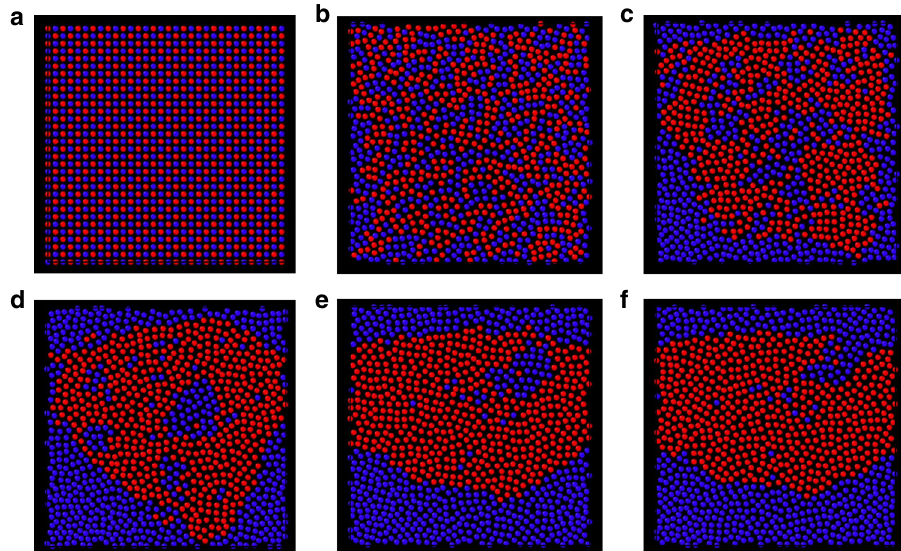
Fig. 8 Segregation of a binary mixture of dissimilar elastic monopoles. a The initial condition for molecular dynamics simulations where the colloidal particles are arranged in a NaCl-like two-dimensional square lattice. Colors of the spheres encode the monopole type: red corresponds to particles with positive elastic colloidal monopole moment, and blue to particles with negative moment. b – f Snapshots sequential in time (increasing from a to f ) showing spatial segregation of distinct colloidal